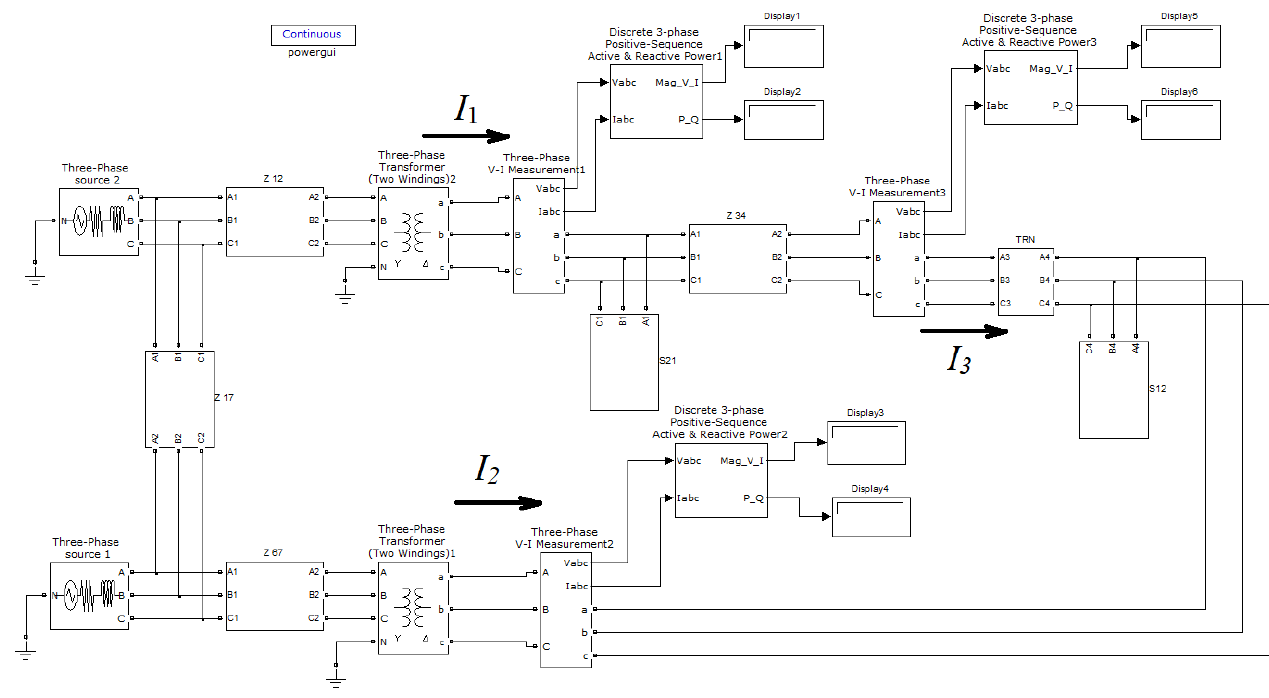
Figure 10. Electrical network model in Matlab Simulink.